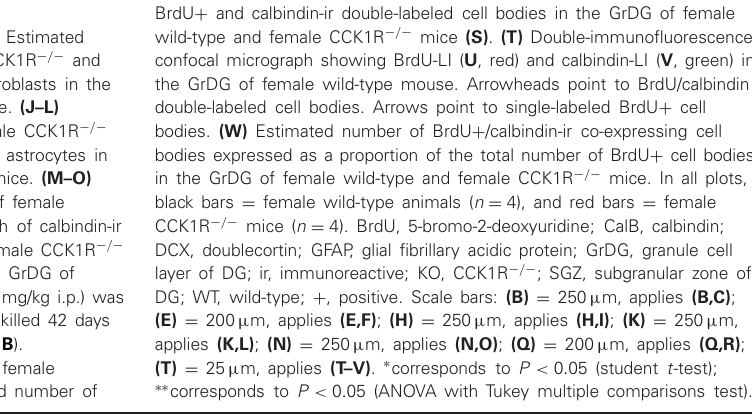
BrdU + and calbindin-ir double-labeled cell bodies in the GrDG of female wild-type and female CCK1R − / − mice (S) . (T) Double-immunofluorescence confocal micrograph showing BrdU-LI ( U , red) and calbindin-LI ( V , green) in the GrDG of female wild-type mouse. Arrowheads point to BrdU/calbindin double-labeled cell bodies. Arrows point to single-labeled BrdU + cell bodies. (W) Estimated number of BrdU + /calbindin-ir co-expressing cell bodies expressed as a proportion of the total number of BrdU + cell bodies in the GrDG of female wild-type and female CCK1R − / − mice. In all plots, black bars = female wild-type animals ( n = 4), and red bars = female CCK1R − / − mice ( n = 4). BrdU, 5-bromo-2-deoxyuridine; CalB, calbindin; DCX, doublecortin; GFAP, glial fibrillary acidic protein; GrDG, granule cell layer of DG; ir, immunoreactive; KO, CCK1R − / − ; SGZ, subgranular zone of DG; WT, wild-type; + , positive. Scale bars: (B) = 250 μ m, applies (B,C) ; (E) = 200 μ m, applies (E,F) ; (H) = 250 μ m, applies (H,I) ; (K) = 250 μ m, applies (K,L) ; (N) = 250 μ m, applies (N,O) ; (Q) = 200 μ m, applies (Q,R) ; (T) = 25 μ m, applies (T–V) . ∗ corresponds to P < 0 . 05 (student t -test); ∗∗ corresponds to P < 0 . 05 (ANOVA with Tukey multiple comparisons